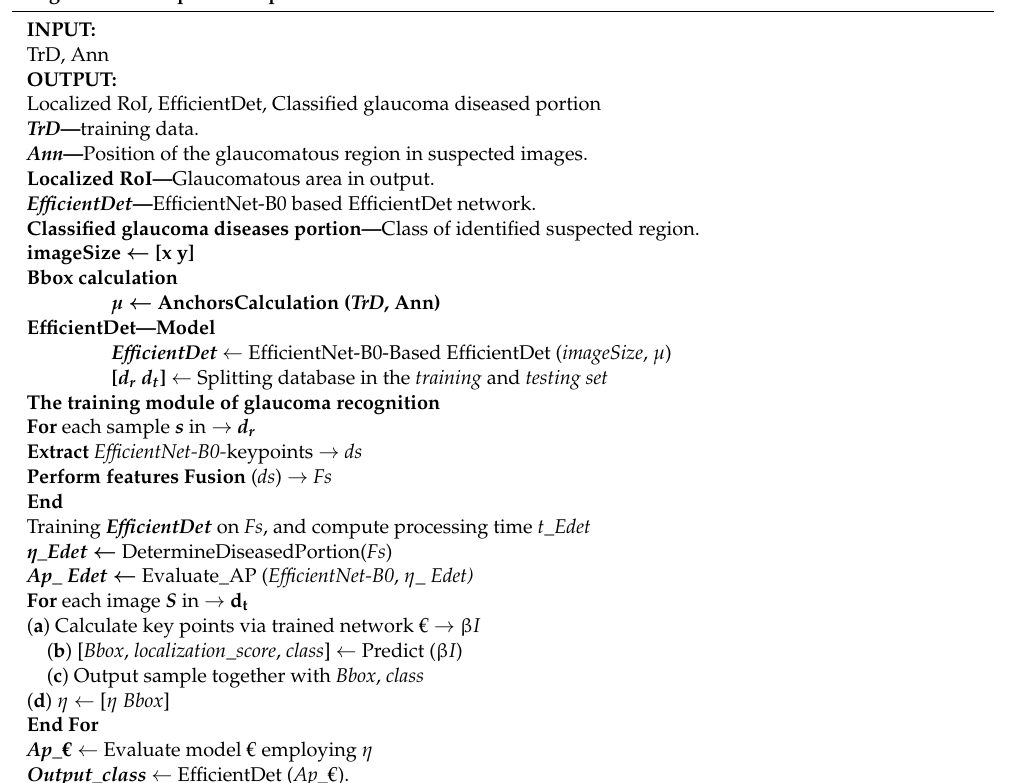
Algorithm 1: Steps for the presented method.